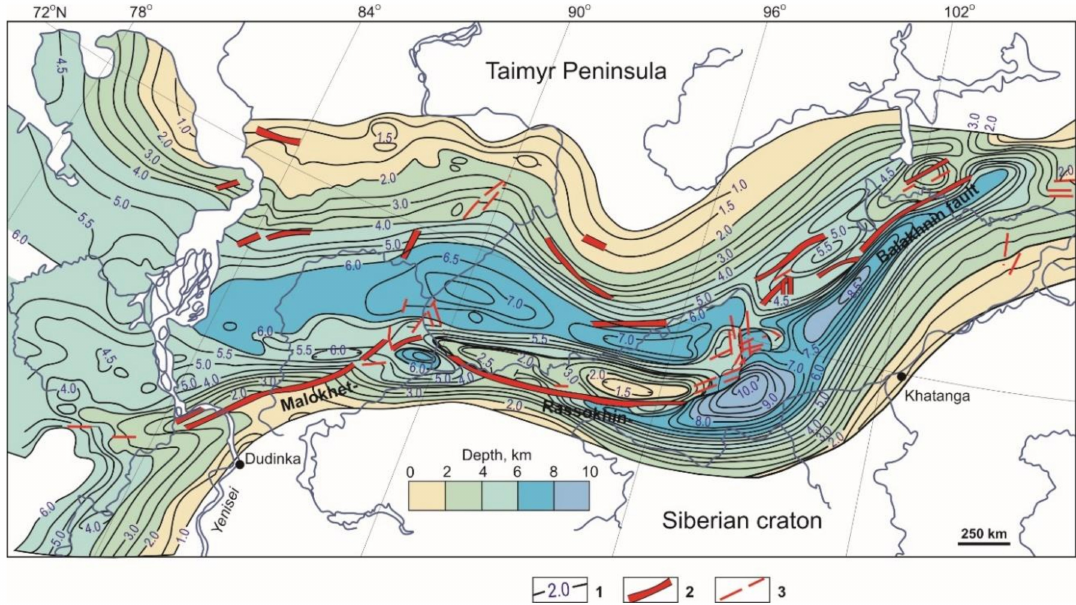
Figure 9. Relief map of the base of the Yenisei-Khatanga basin Jurassic infill (composed by V.Yu. Bogatova, V.V. Grebenyuk, T.A. Divina) from Reference [70]. 1—stratoisohypses (depth in km) for the base of the Jurassic—erosional truncation intervals of the Triassic formations in the eastern basin (seismic reflector V) and of the unconformable bedding of the Zimnii Formation on the Triassic rocks in the western half (seismic reflector III); 2—fault zones according to seismic data; 3—faults according to geological and geophysical